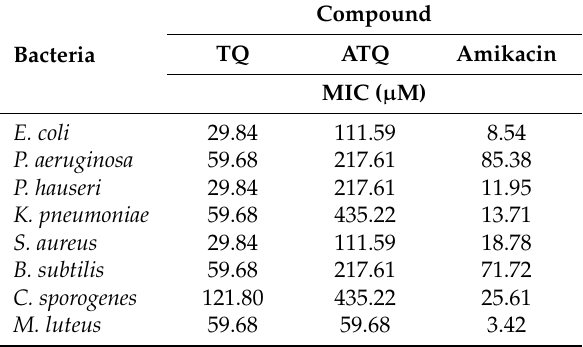
Table 1. In vitro antibacterial activity represented as minimum inhibitory concentration (MIC/ µ M) values of investigated compounds.